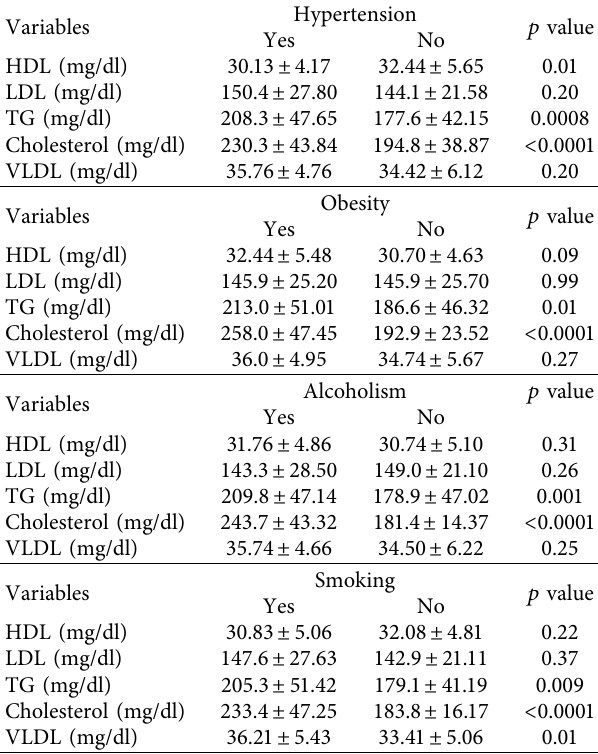
Table 3: Comparison of biochemical parameters with different risk factors among T2DM